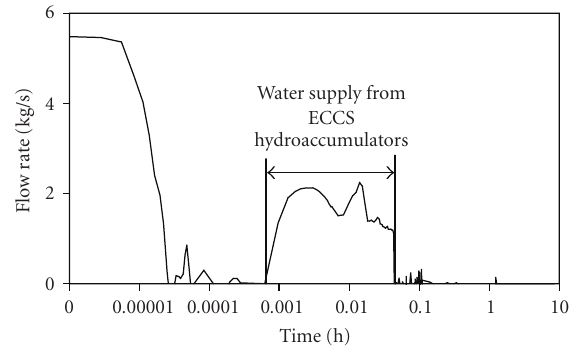
Figure 13: MCP pressure header break with failure of ECCS. Coolant flow rate through the single FC.